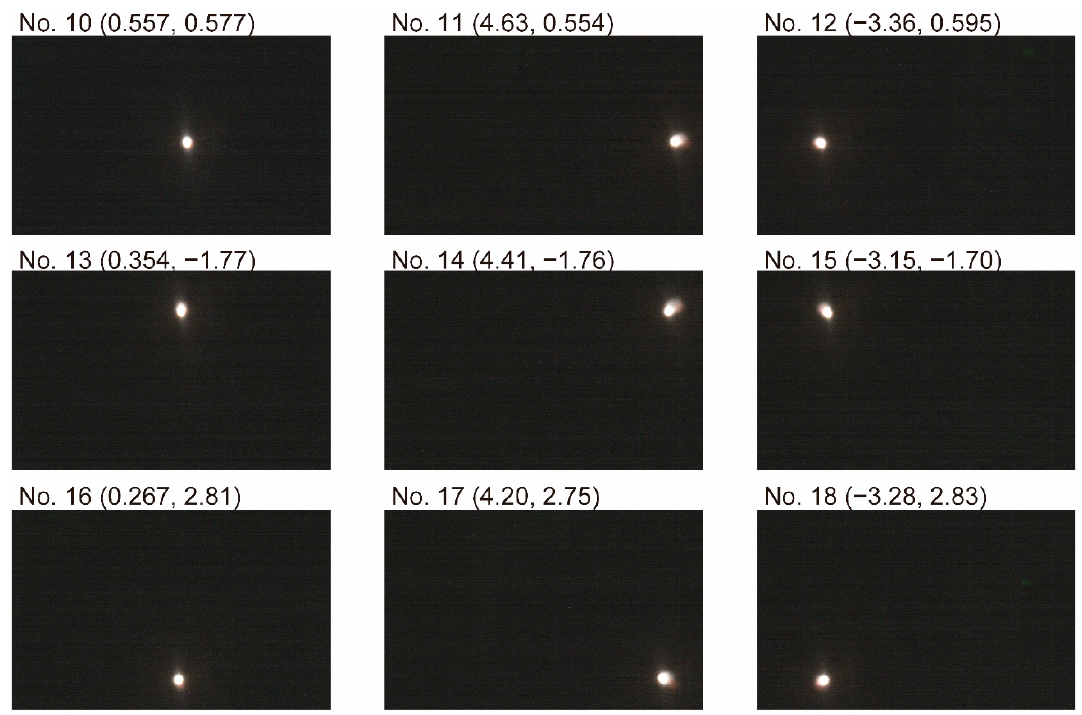
Figure A4. Captured color images of the light source at 1 m from the hybrid lens.